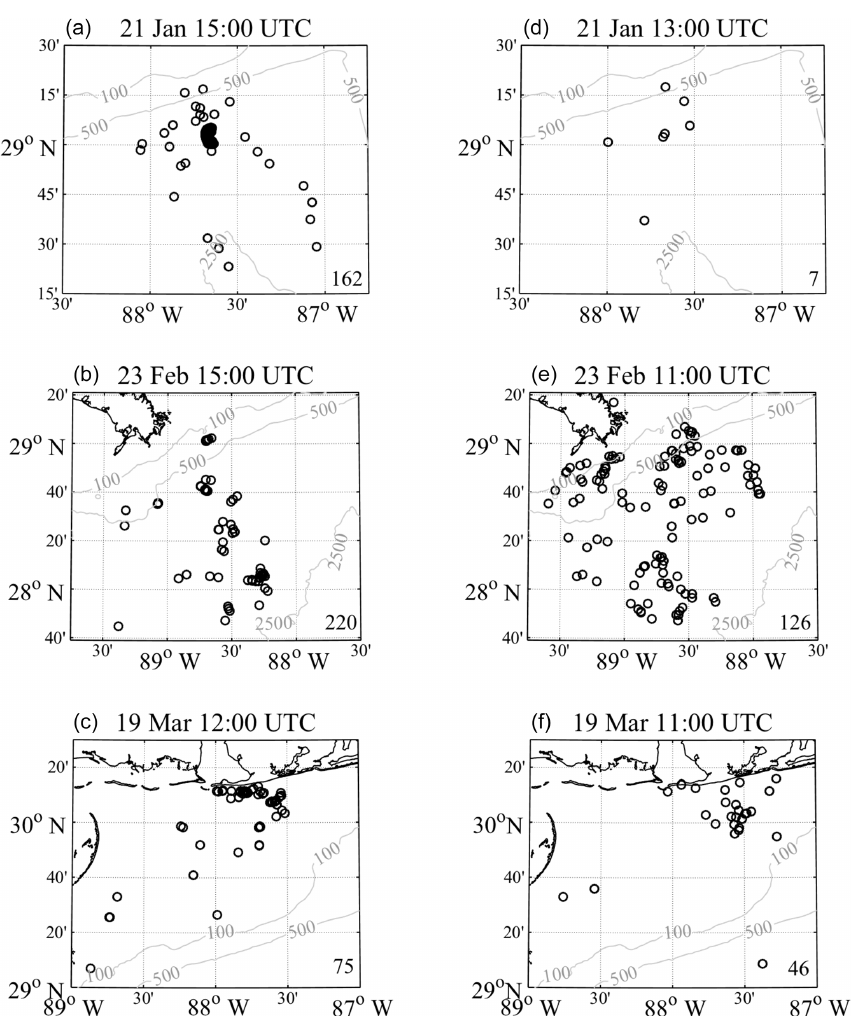
Figure 6. Drogued (a, b, c) and undrogued (d, e, f) drifters used to create Eulerian velocity fields of the pre-wind-event regional circulation estimates using LAVA. Raw drifter locations are plotted at the end of the hour over which the velocity fields are created. Numbers in the bottom right corner of plots display the number of drifters used for each velocity field construction. Panels correspond to subdomains shown in Fig.